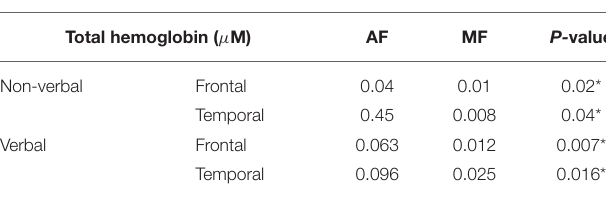
TABLE 3 | A comparison between hemodynamic activity of the frontal and temporal lobes during fNIRS. Hemodynamic activity of frontal and temporal lobes Total hemoglobin ( µ M) AF MF P-